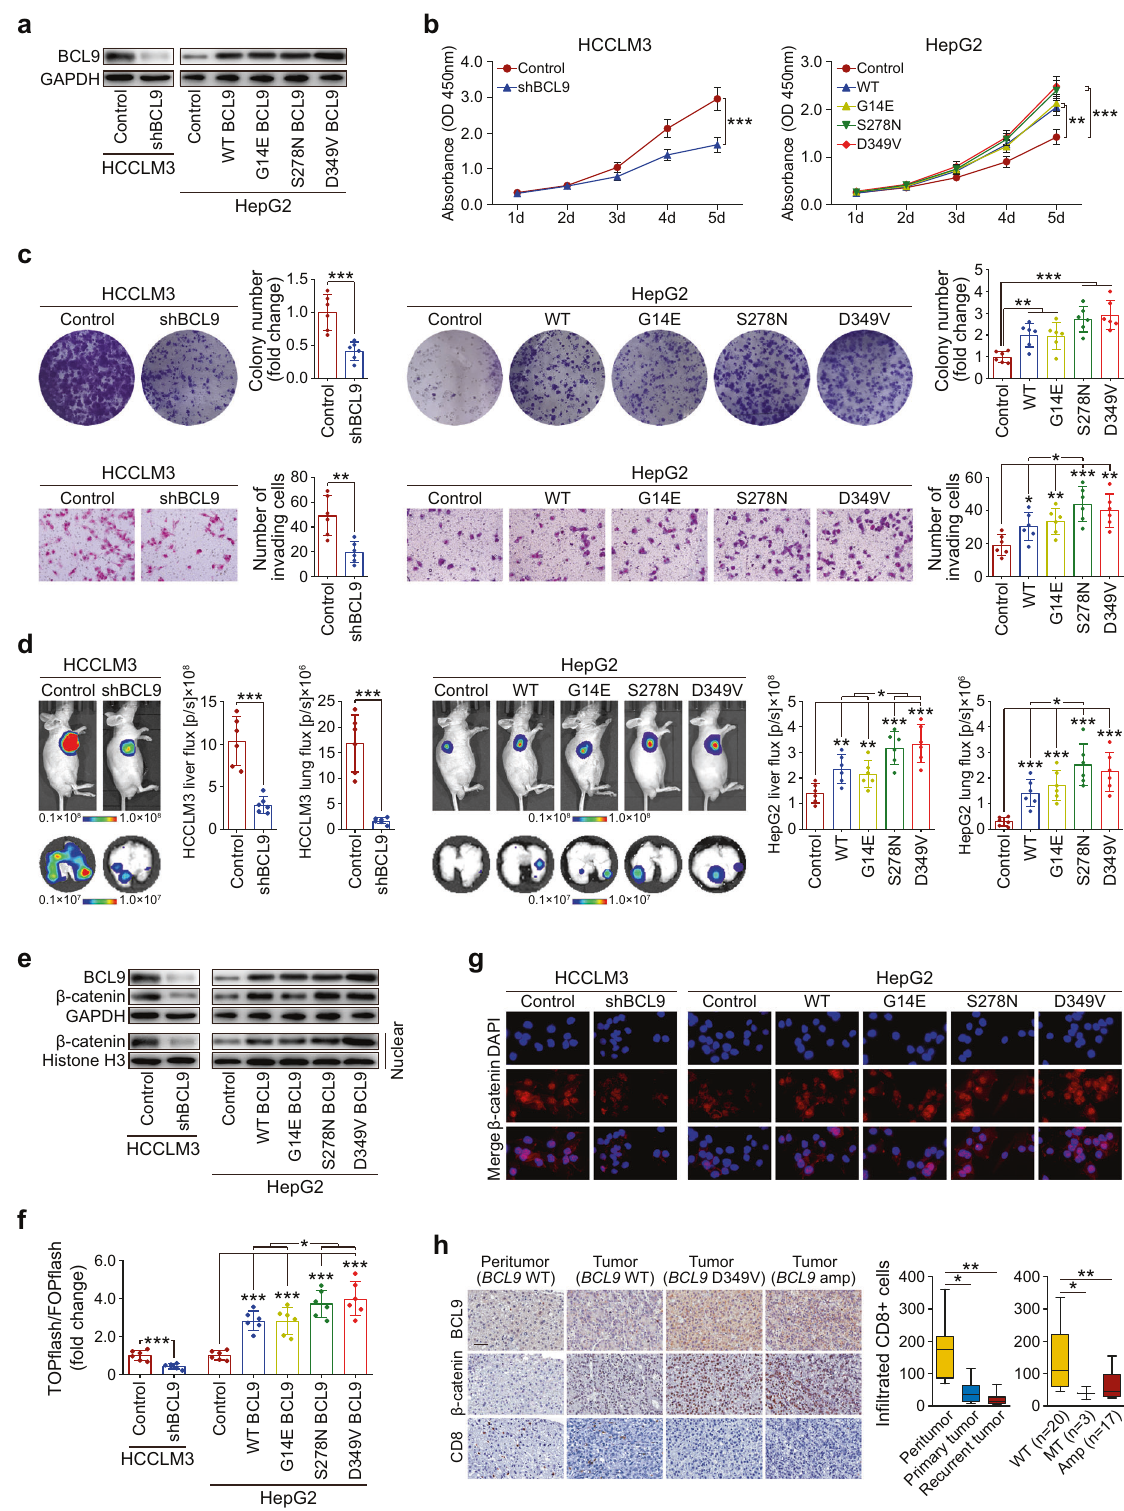
DISCUSSION Tumor evolution is a dynamic process both spatially and temporally. A better understanding of that evolutionary process would provide clues to guide effective therapies. Using whole- genome analysis of matched primary and early-recurrent